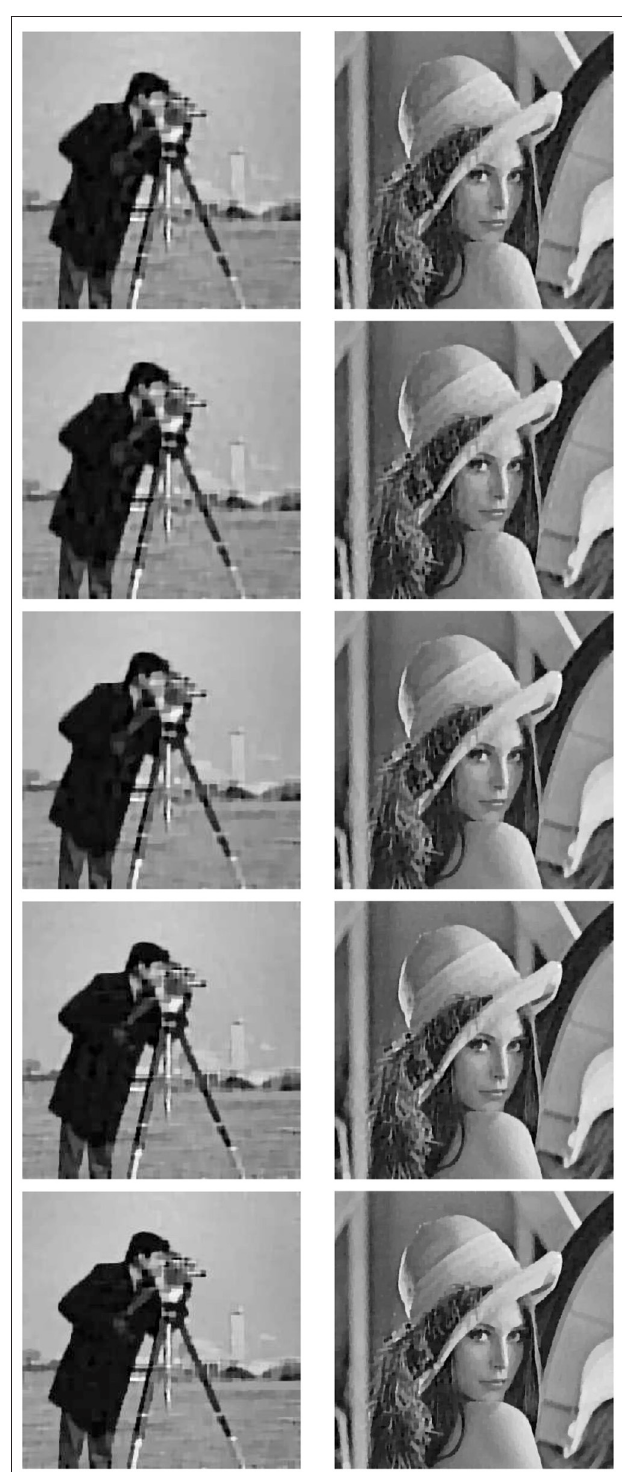
FIGURE 4 | Recovered images of “Cameraman” and “Lena” (from top row to bottom row) with the L1-TV model for images blurred by the (21 , 10)-GBM and corrupted by impulsive noise of level p = 0.3. Row 1: the CP; Row 2: ZBO; Row 3: Algorithm 1; Row 4: Algorithm 2 with Equation (53); Row 5: Algorithm 2 with Equation